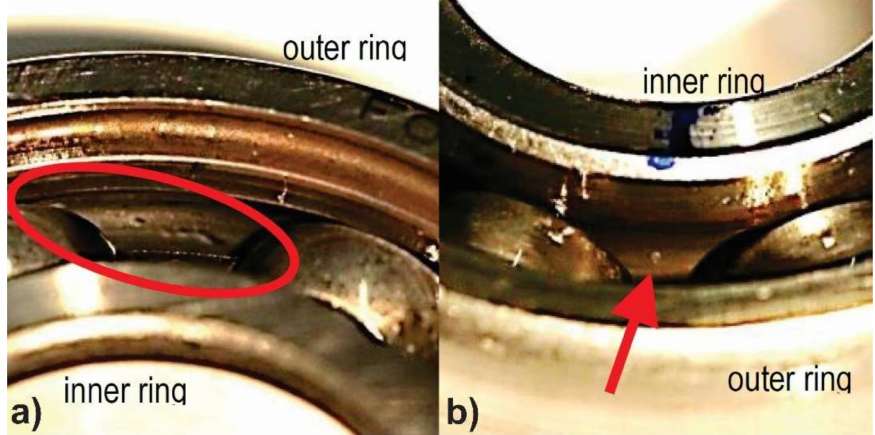
Figure 2. Examples of bearing damage visual representation: ( a ) Indentation at the raceway of the outer ring; ( b ) Small pitting at the raceway of the inner